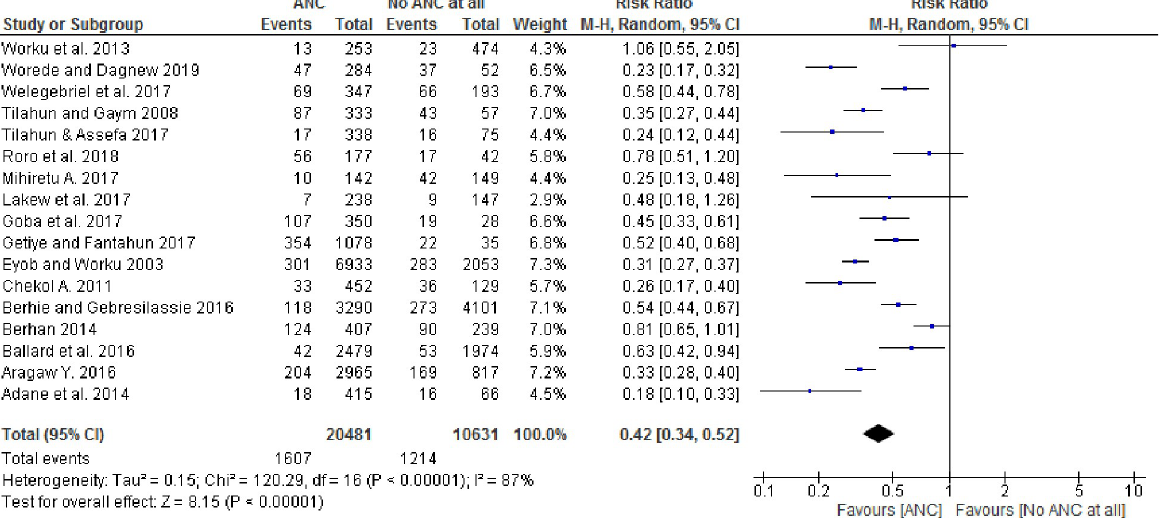
Fig 2. Forest plot showing pooled effect of ANC on the perinatal outcomes in Ethiopia.